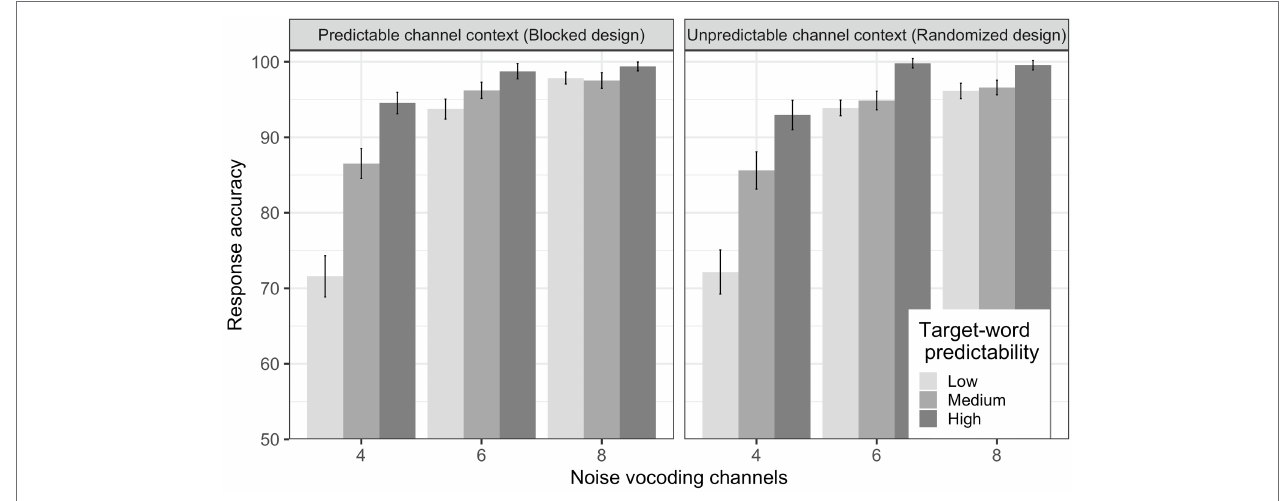
FIGURE 2 | Mean response accuracy for the blocked design (left) and the randomized design (right). Error bars represent standard error of the means.